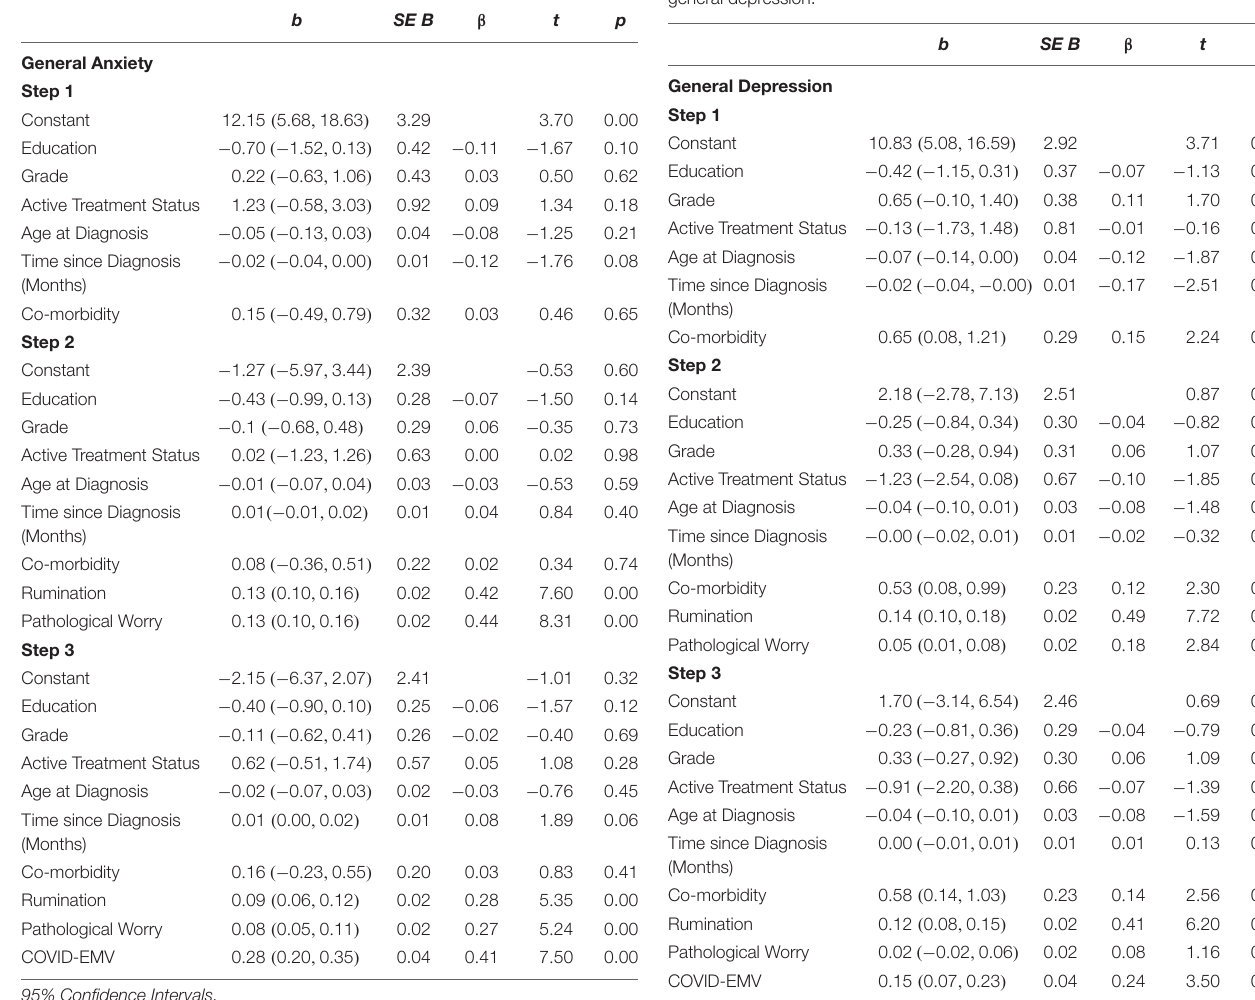
TABLE 4 | Hierarchical regression analyses for the predictors of general anxiety. TABLE 5 | Hierarchical regression analyses for the predictors of